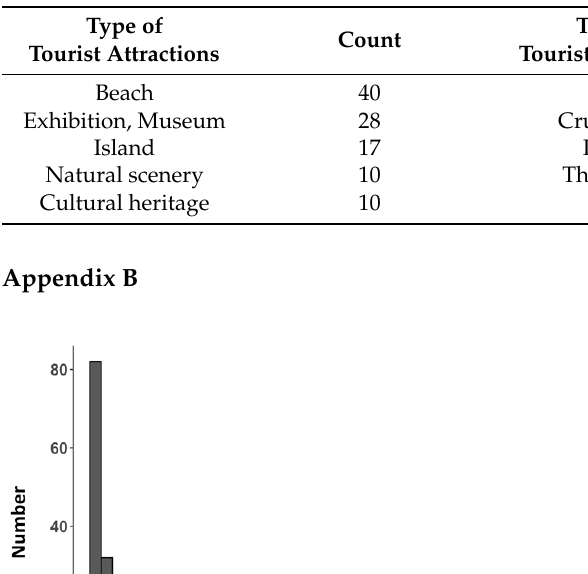
Table A1. Information by attraction type of coastal tourism visitation data.